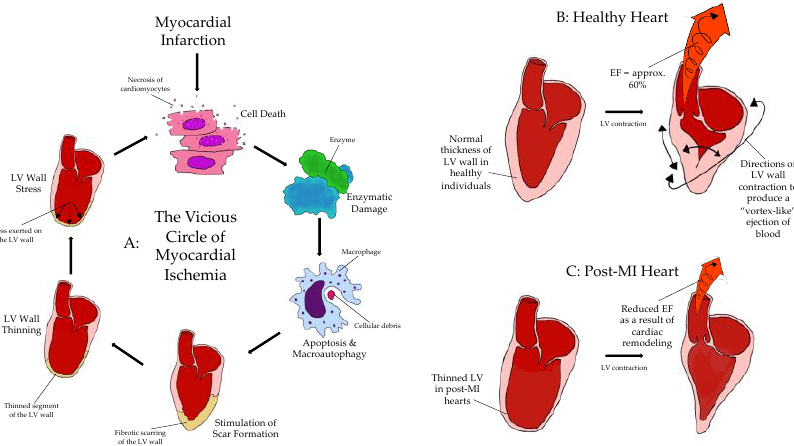
Figure 1. Vicious circle of myocardial ischemia and ventricular wall remodeling after MI. EF: ejection fraction. ( A ): representative diagram of the vicious circle of myocardial ischemia, kickstarted by an initial myocardial infarction. ( B ): contraction of the LV in a healthy heart and the EF produced as a result of efficient contraction. ( C ): contraction of a post-MI heart and the reduced EF produced as a result of altered cardiac architecture.